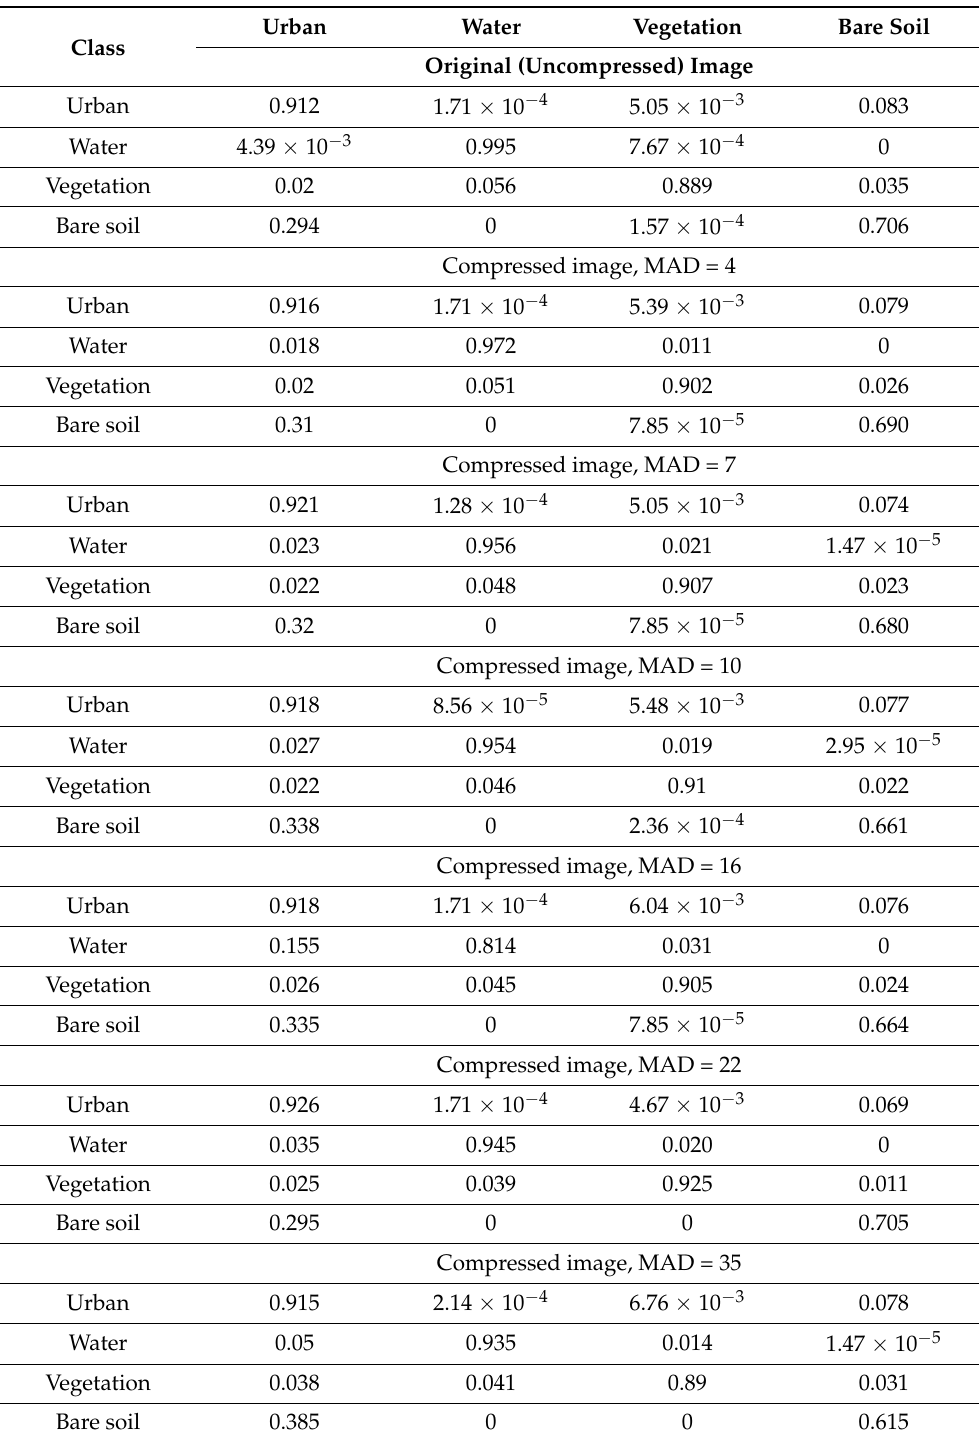
Table 6. Probabilities of correct classifications for particular classes depending on image